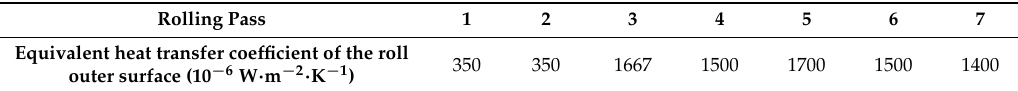
Table 4. Equivalent heat transfer coefficient of the roll outer surface.